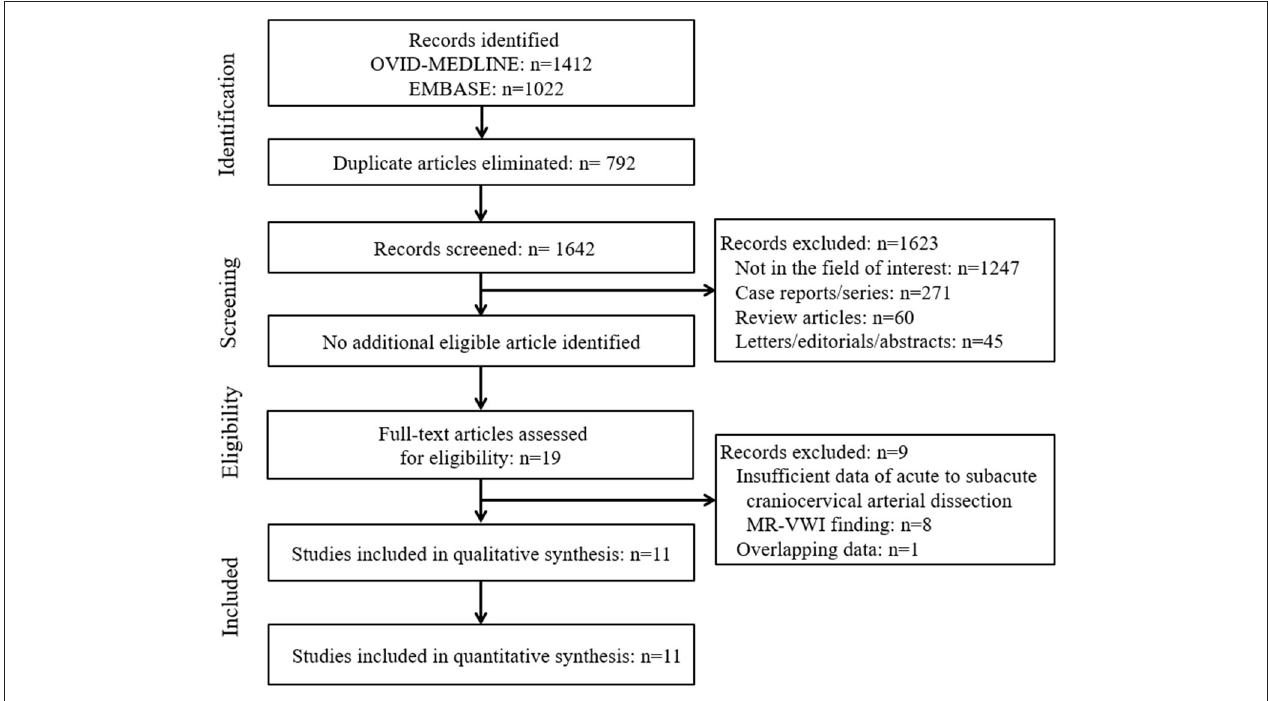
FIGURE 1 | Flow diagram of the study selection